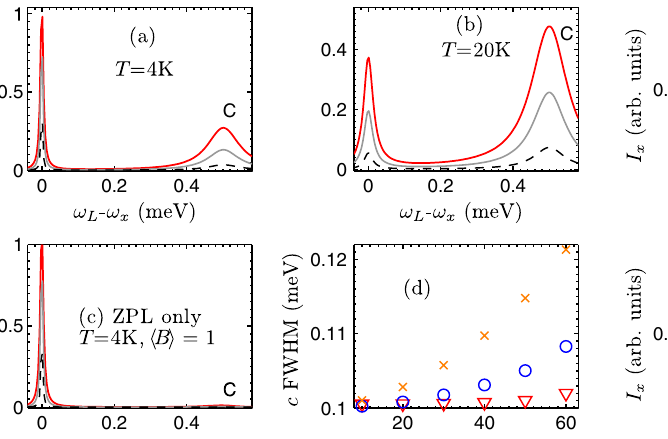
¼ (cid:1) 0 : 5 meV cx